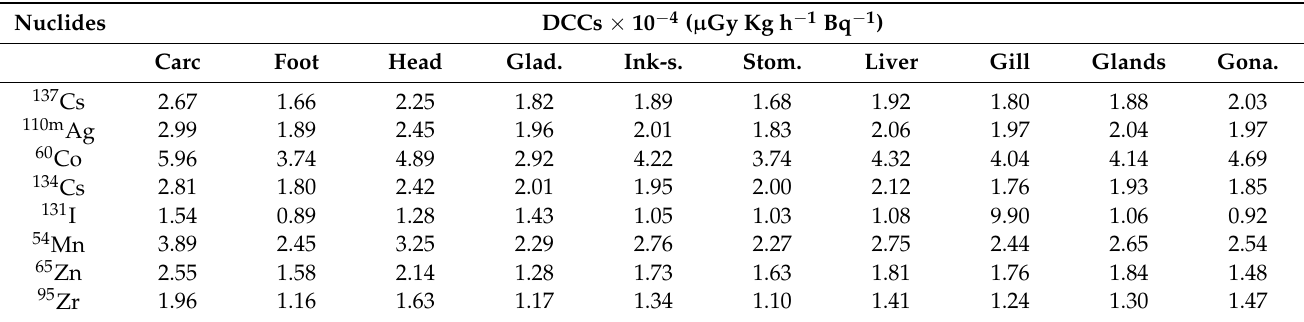
Table 5. External dose conversion coefficient of squid organs.